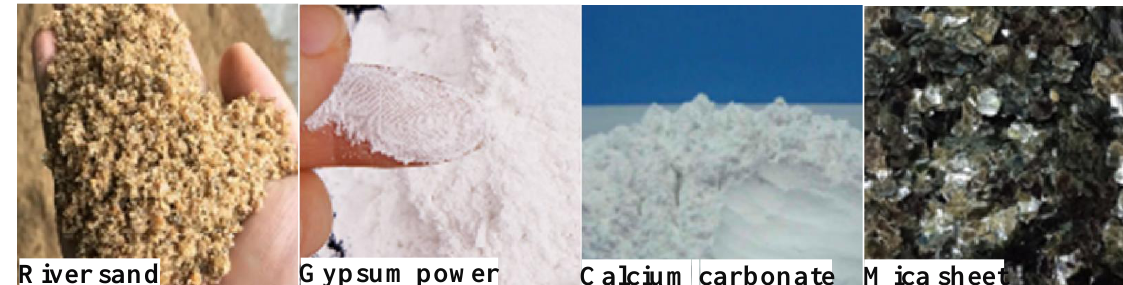
Figure 8. Similar materials.